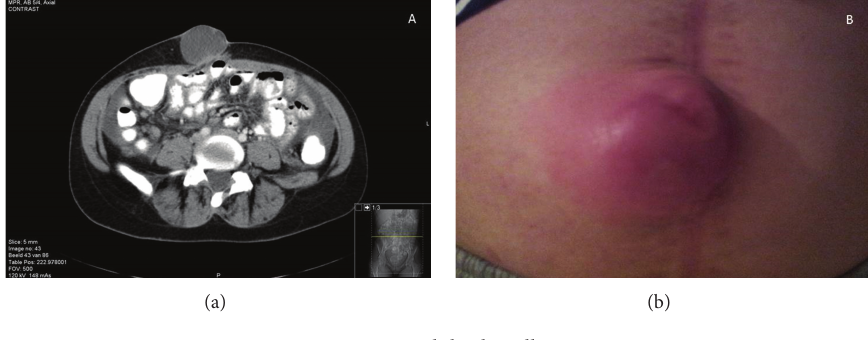
Figure 2: Umbilical